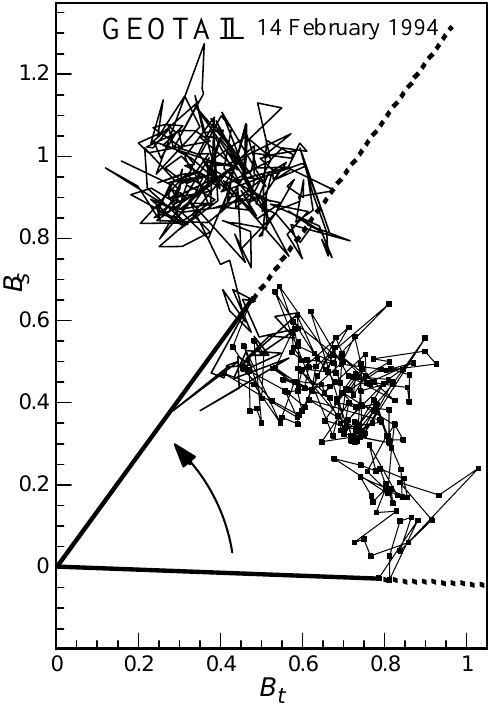
Fig. 2. Filled squares are data points across the R-layer. They show that the magnetic field rotates by an angle of ∼ 58 ◦ about the normal direction of the shock surface, while its magnitude re- mains nearly constant. The arrow indicates the direction of field rotation. Thin lines are data points during an extended period of 20 s in the post R-layer